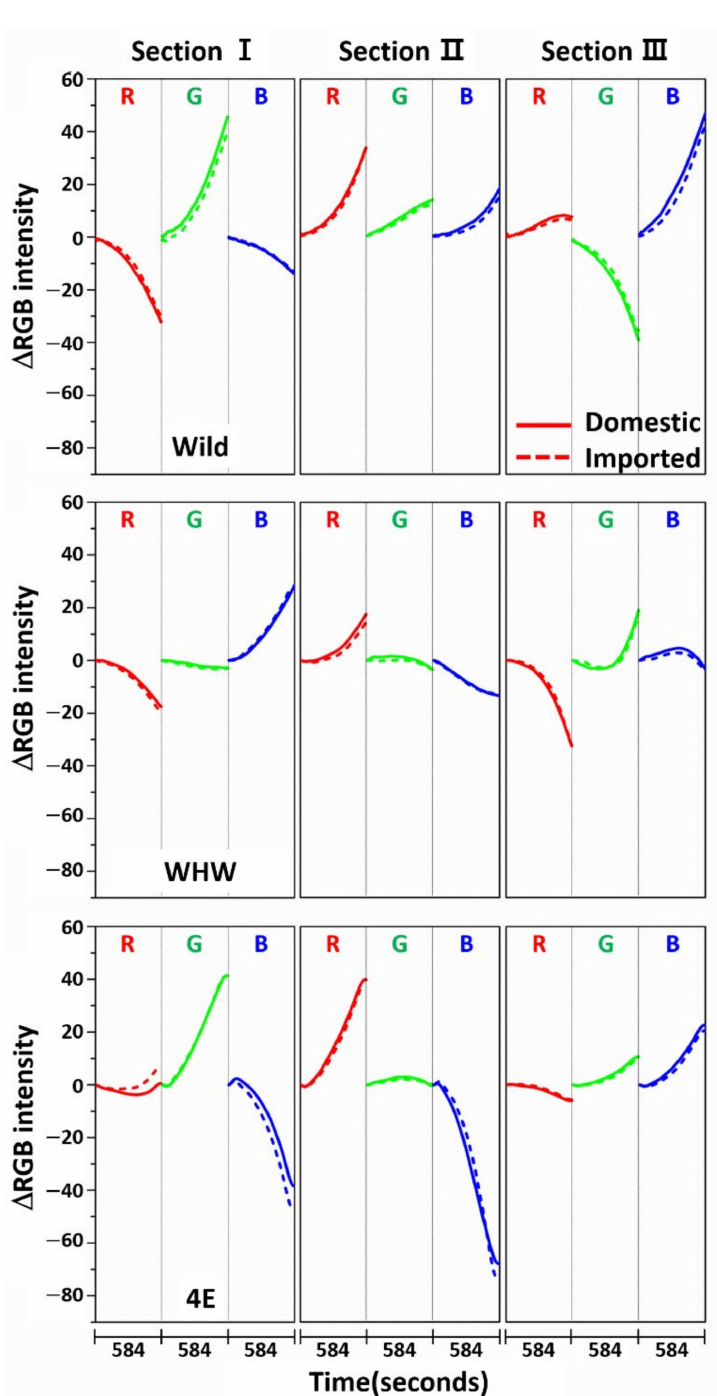
Figure 6. Variation of average ∆ RGB intensity occurring in the three sections of Wild, WHW, and 4E sensors in the measurement of onion samples (solid line: domestic sample, dotted line: imported